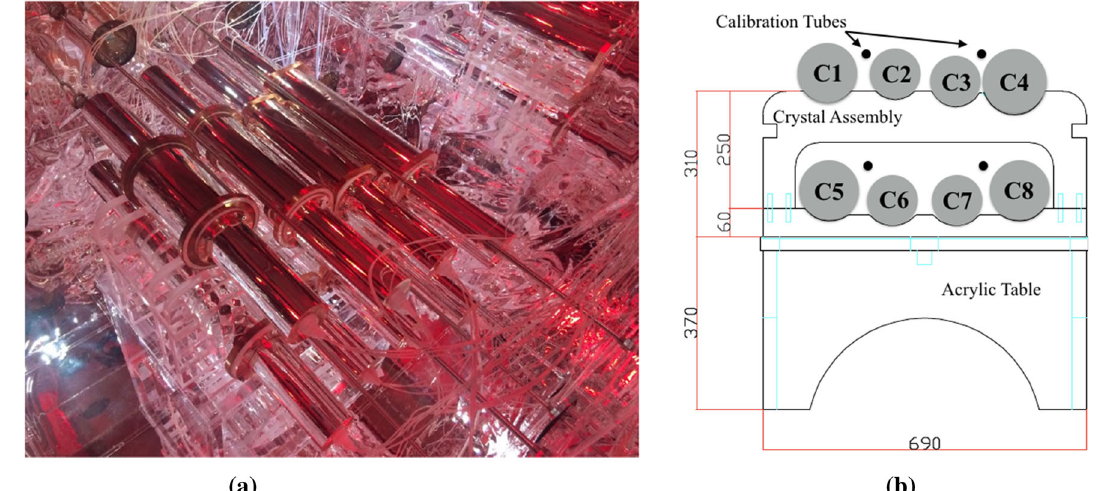
Fig. 3 The 4 × 2 NaI(Tl) crystal array. Each crystal has two, 3-inch PMTs and is encapsulated in a thin Polytetrafluoroethylene (PTFE) reflector and copper casing. The crystal arrangement is shown in ( a ) and a diagram of the crystal arrangement is shown in ( b ). An acrylic